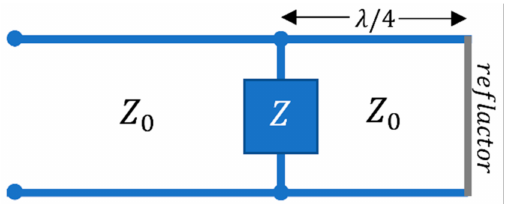
Figure A3. Schematic model of transmission line with pixel with impedance Z and λ /4 transformer for perfect matching.